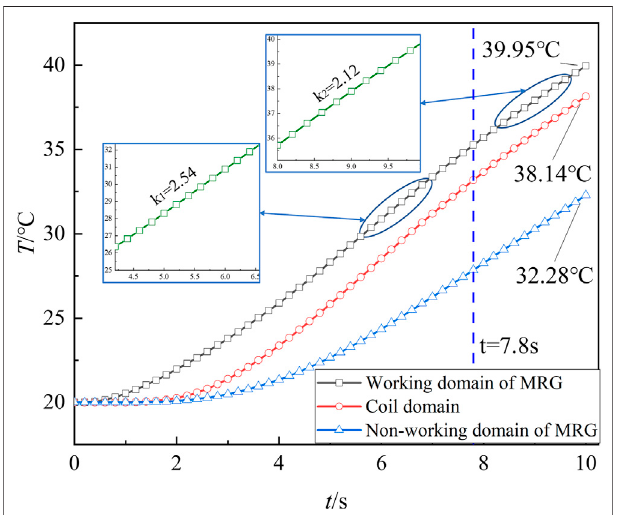
FIGURE 14 | Temperature rise curve of each domain in working condition Ⅲ